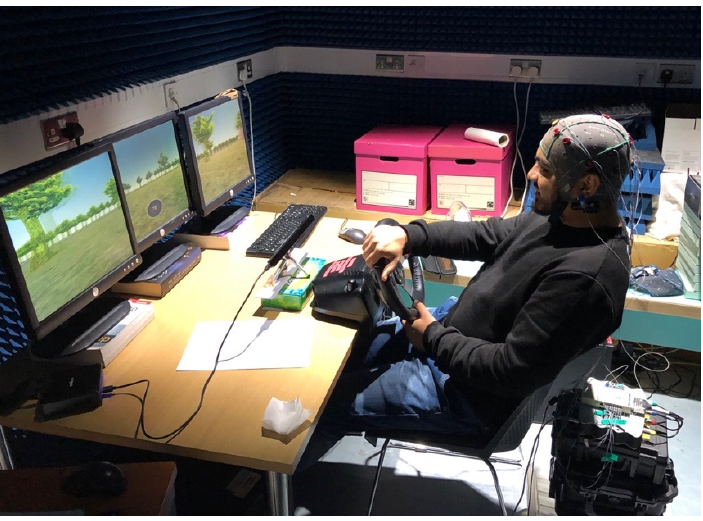
Figure 1. A participant undertaking a test drive with the driving